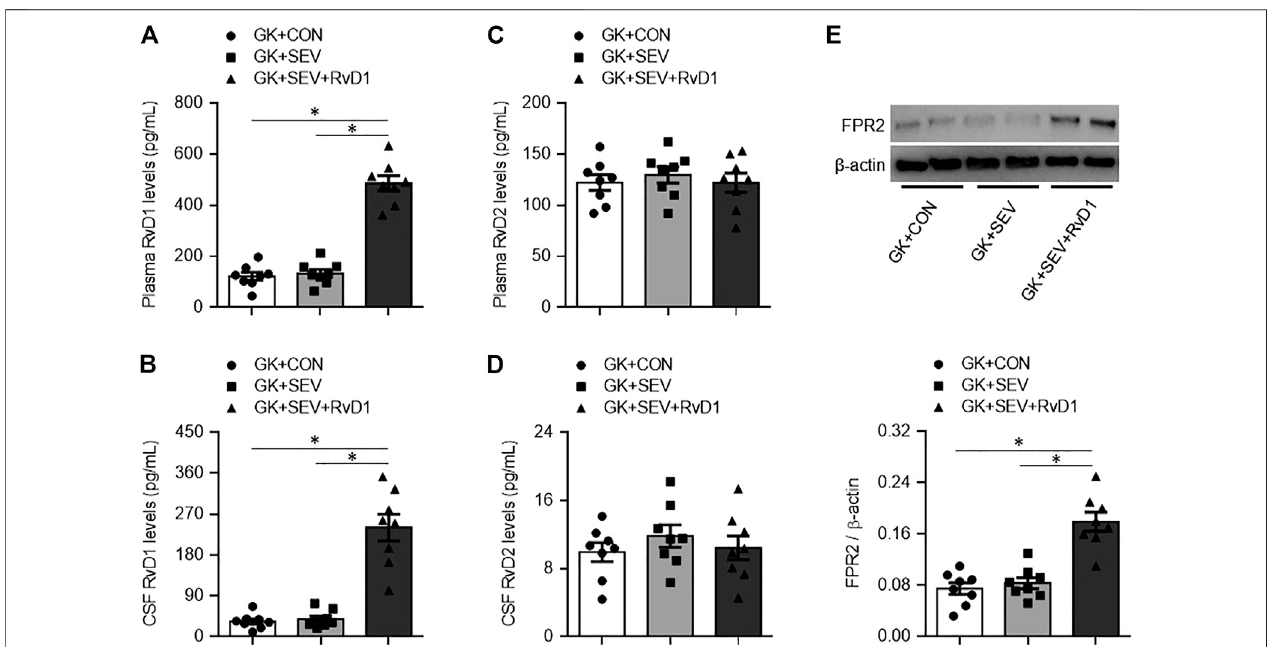
FIGURE 2 | Levels of resolvin D1 (RvD1) and resolvin D2 (RvD2) in plasma (A and C) and cerebrospinal fl uid (CSF) (B and D) and protein expression of their receptor FPR2 in the hippocampus (E) in type 2 diabetic Goto-Kakizaki (GK) rats after control (CON) or sevo fl urane (SEV) exposure and in exogenous RvD1-treated GK rats after SEV exposure. Data are presented as mean ± SE (n (cid:1) 8 for each group). * p < 0.05.